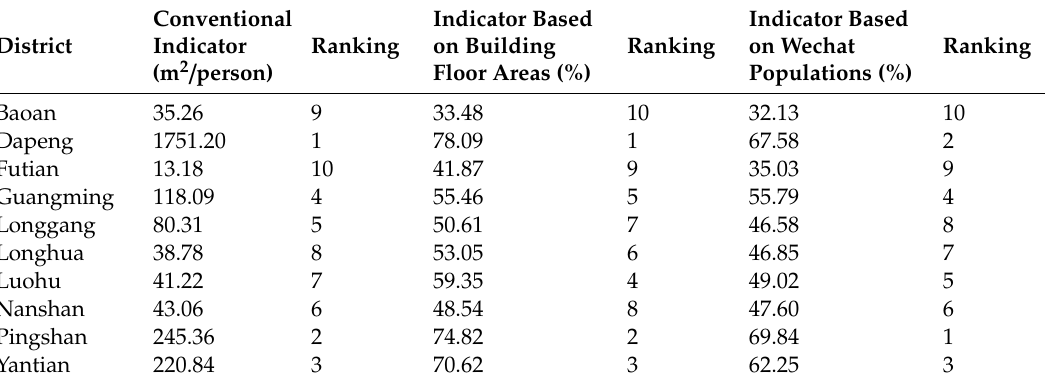
Table 2. Ranking of districts by the indicators of green